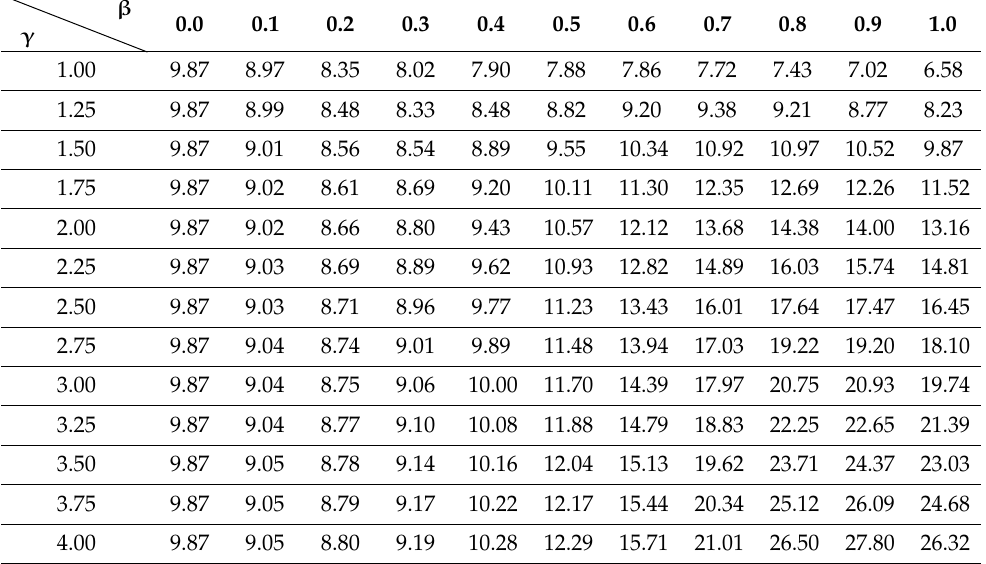
Table 3. Values P g /P d for α = 0.5 and for different values β and γ